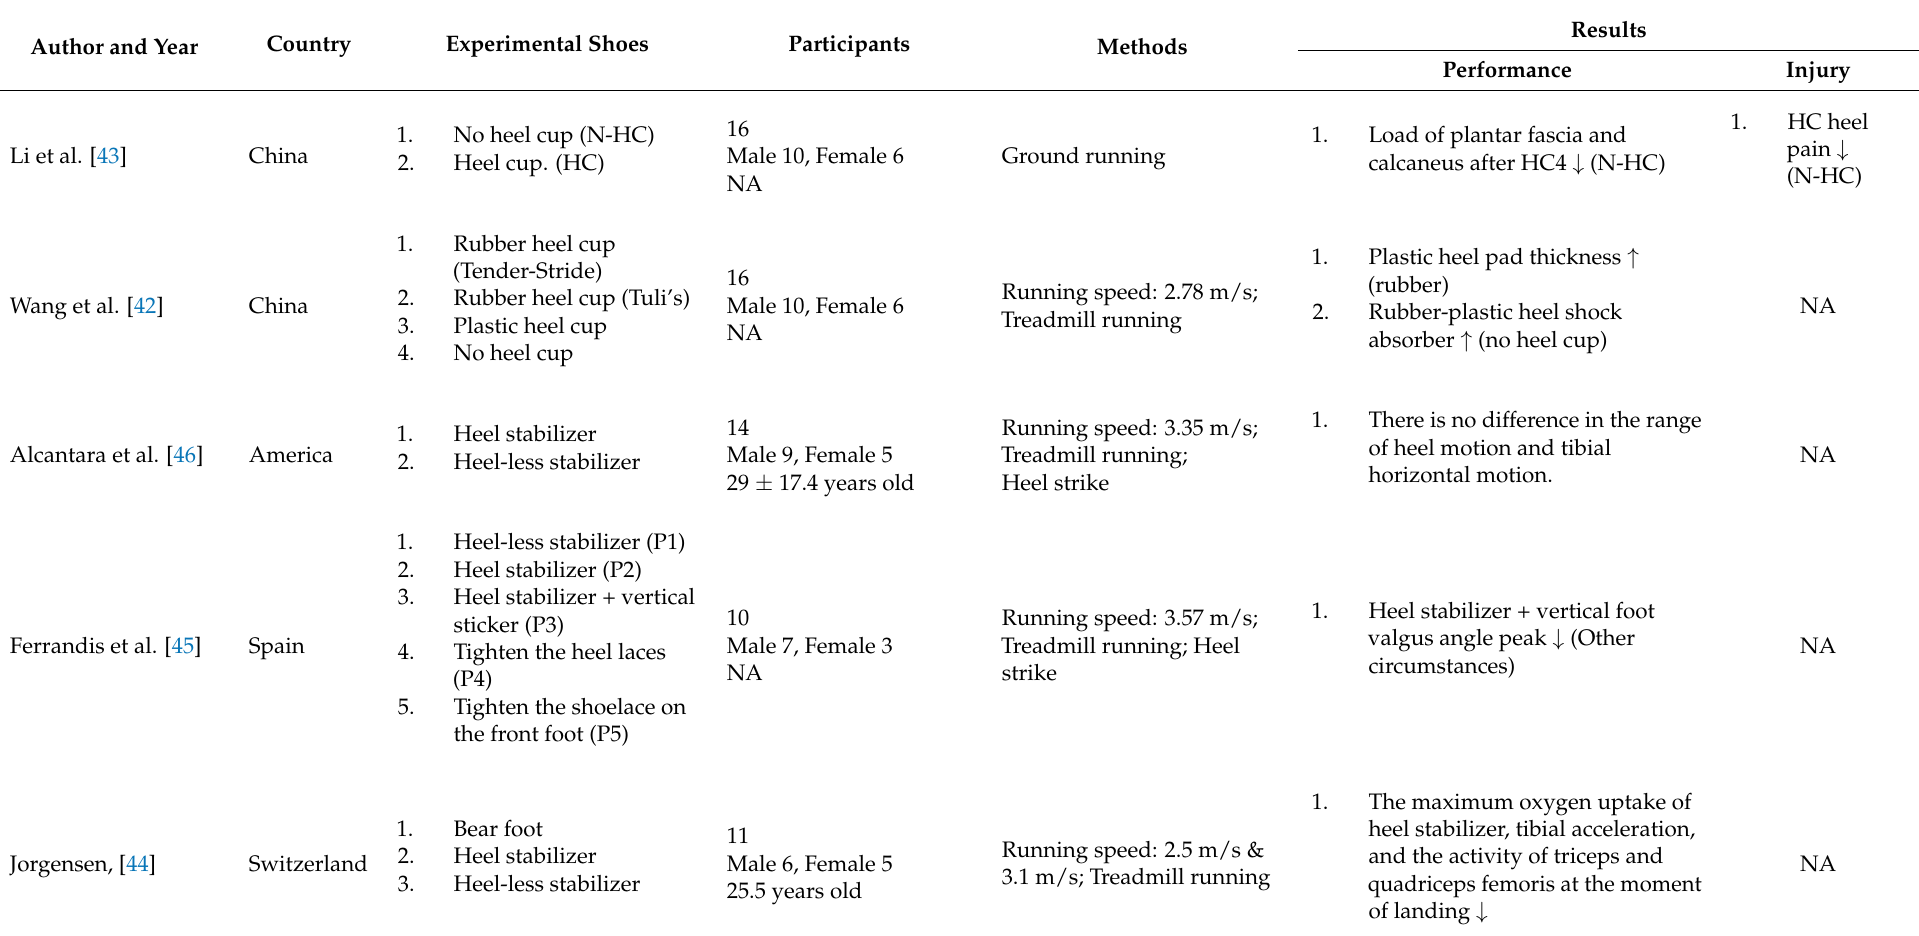
Table 6. The influence of running shoes’ heel stabilizers on running performance and related